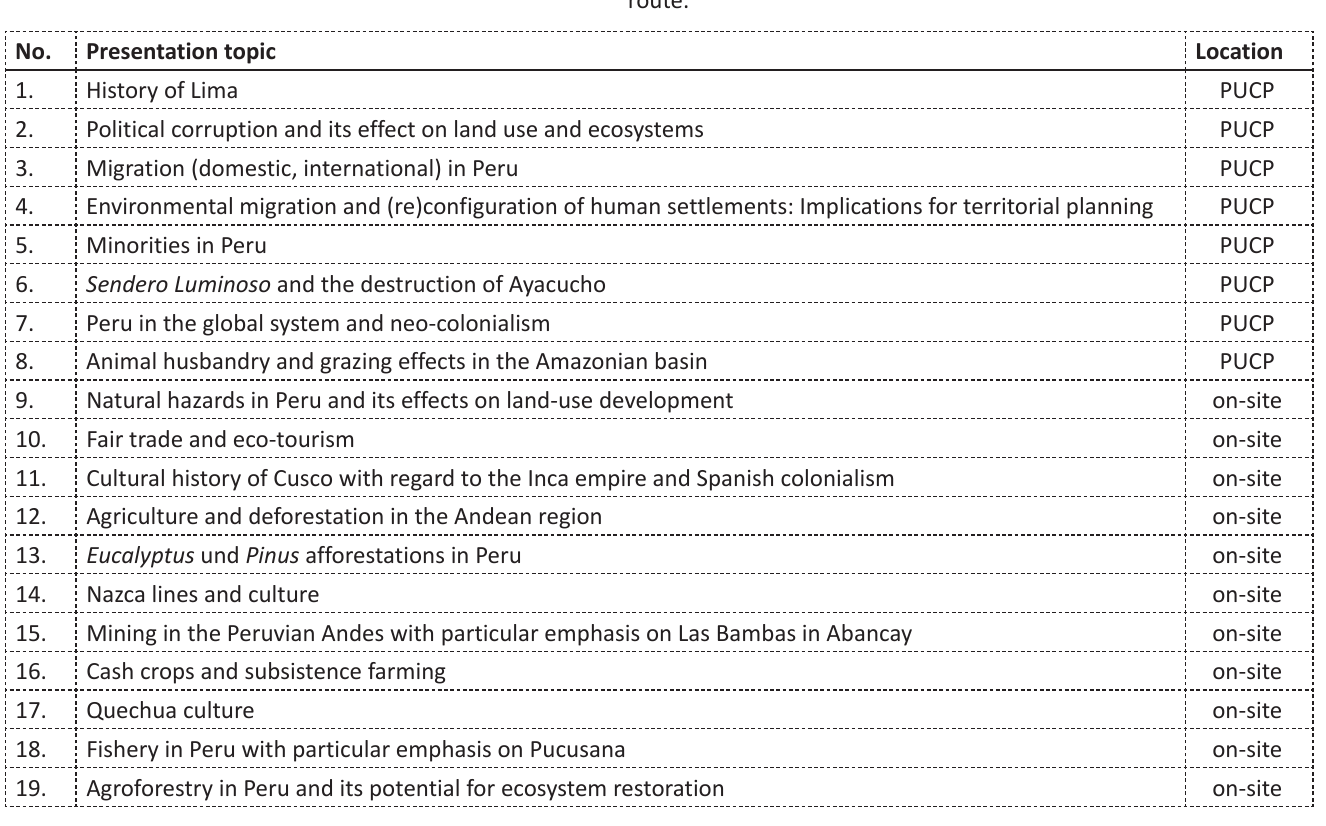
Table 4: Topics which were presented by the students during the interdisciplinary excursion to Peru in 2019, addressing the social as well as the natural sciences, partly held during an introductory seminar at the PUCP in Lima and partly on-site on the excursion route.